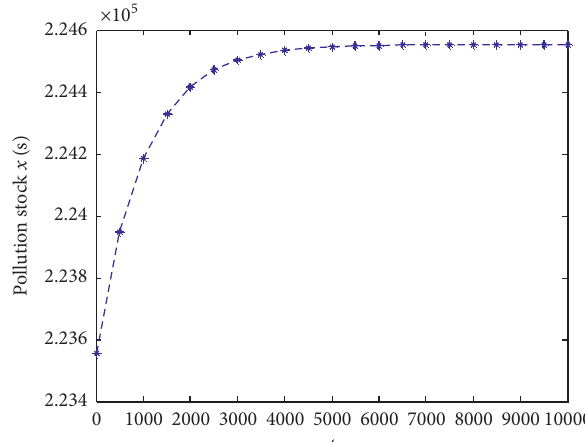
Figure 1: The pollution stock that changes over time.